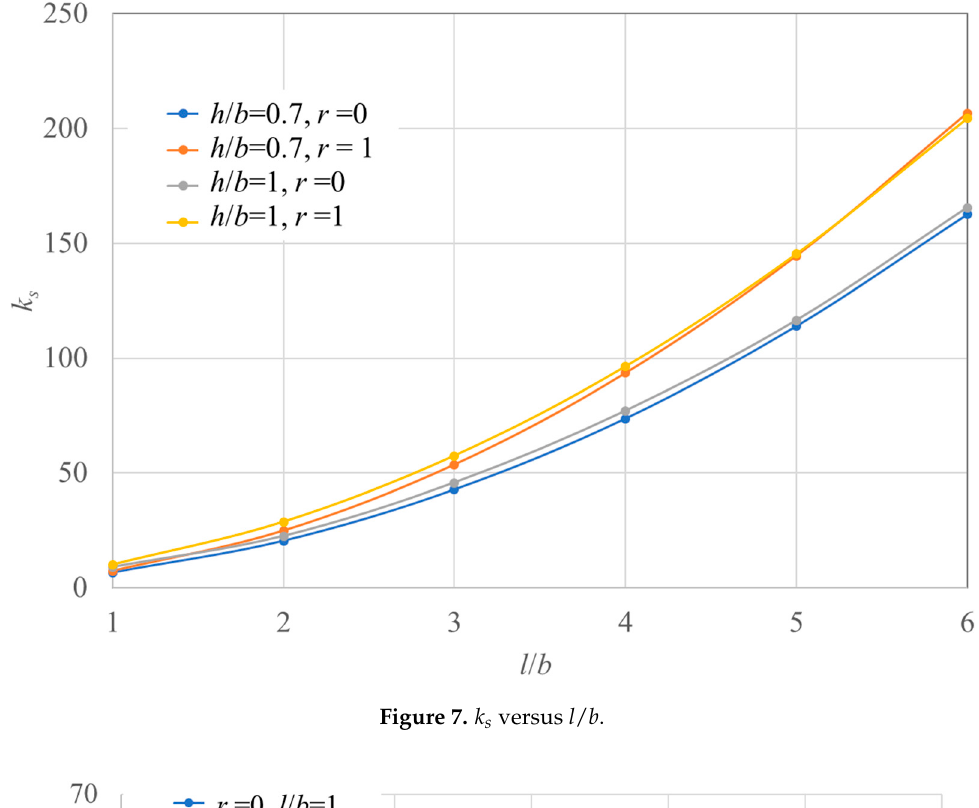
Figure 7. k s versus l / b .